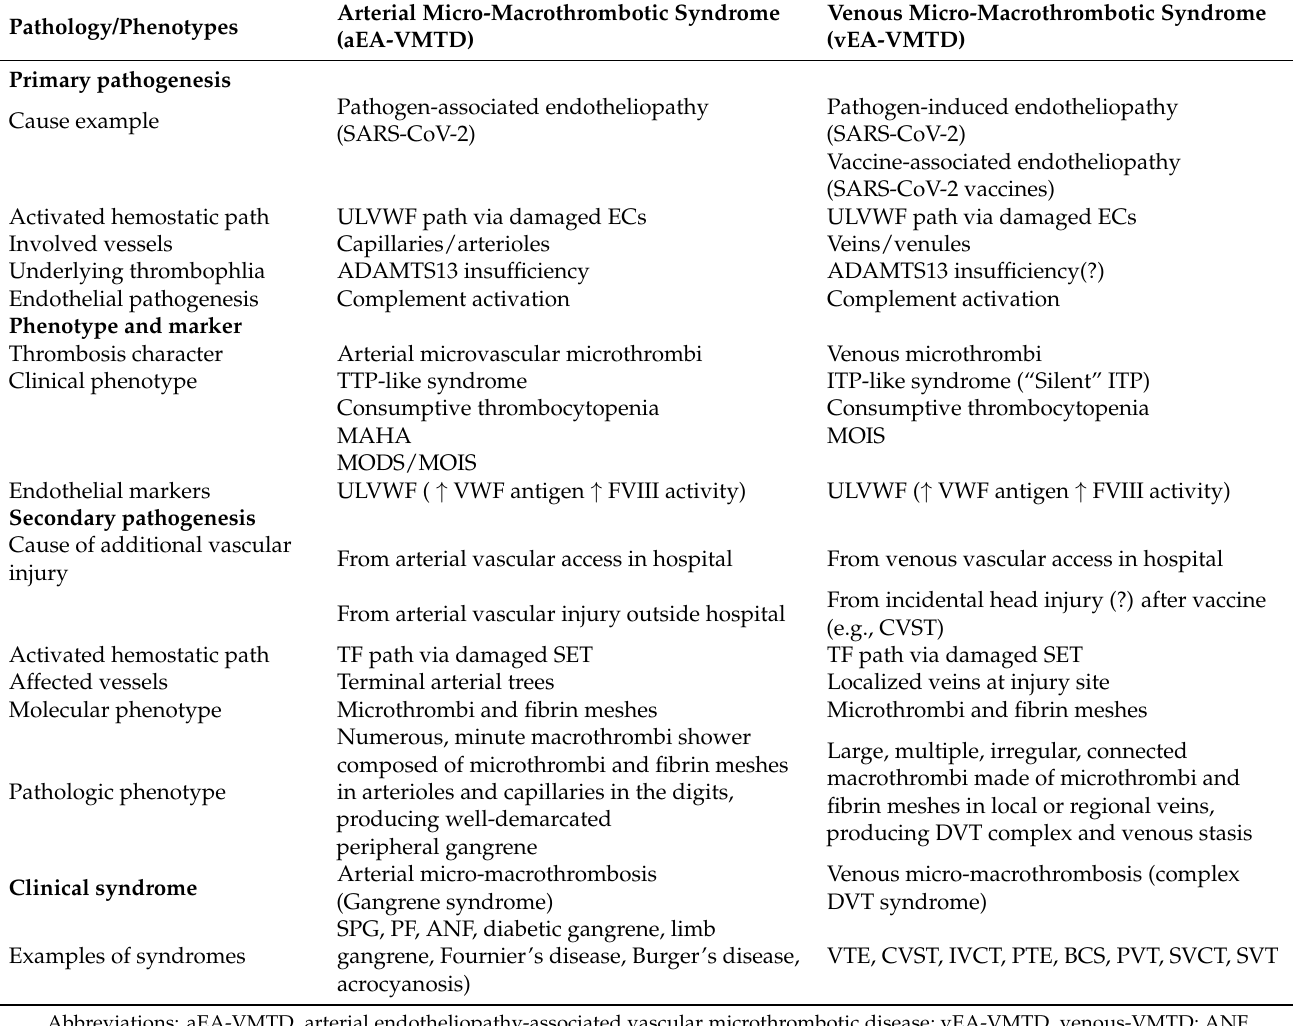
Table 3. Spectrum of combined micro-macrothrombotic